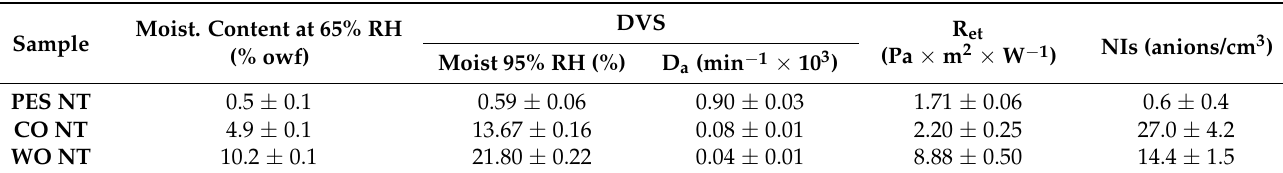
Table 1. Moisture at 65% RH, Moisture at 95% RH and Apparent Diffusion by DVS, R et and Negative Ions (NIs) for non-treated fabrics